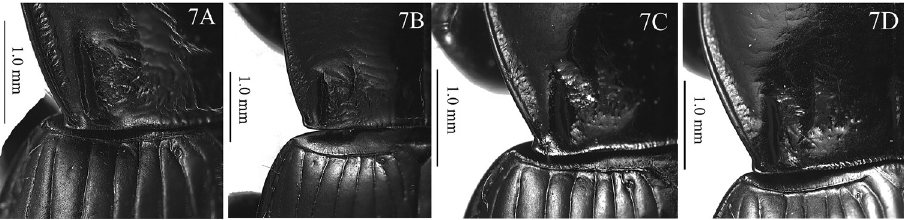
Figure 7. Pronotum left posterior angle and basal area of Pterostichus ( Feroperis ) spp. n. A–B P. silvestris C–D P. maryseae